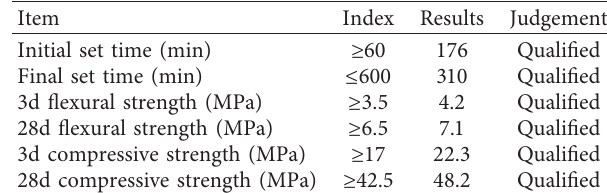
Table 2: Basic properties of cement.